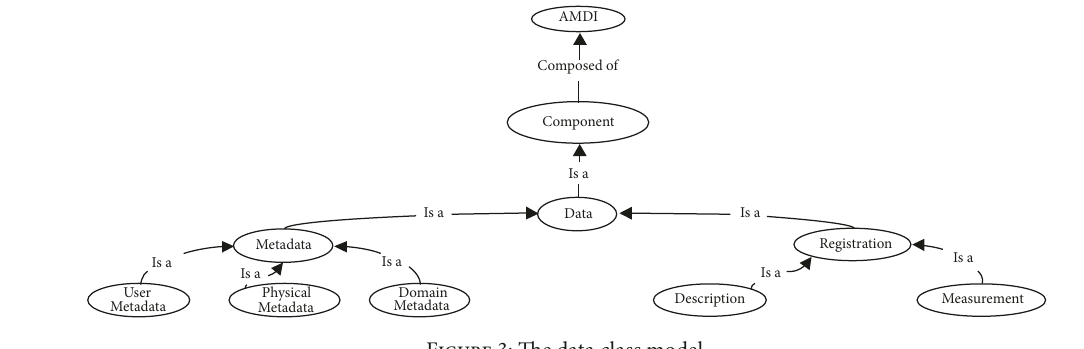
Figure 3: The data class